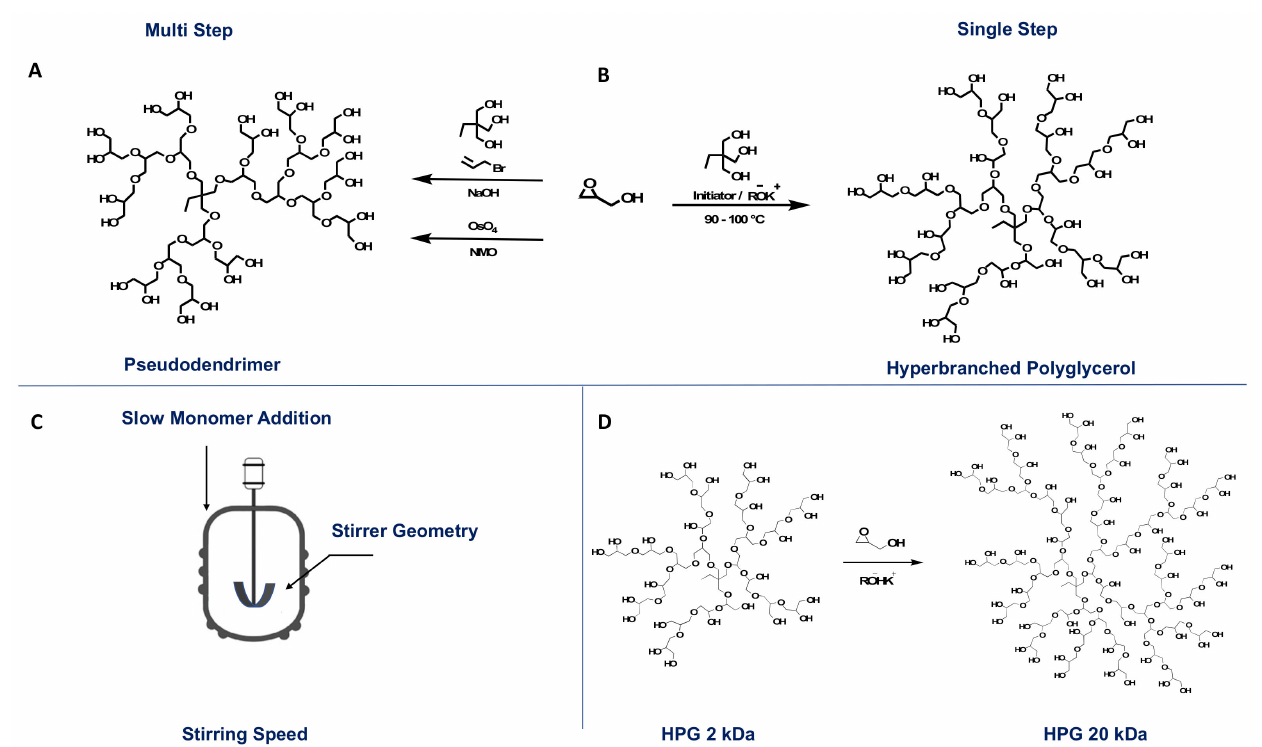
Figure 2. Top: ( A ) Pseudodendrimer, ( B ) HPG. Bottom: ( C ) reaction parameters, ( D ) (macromonomer,